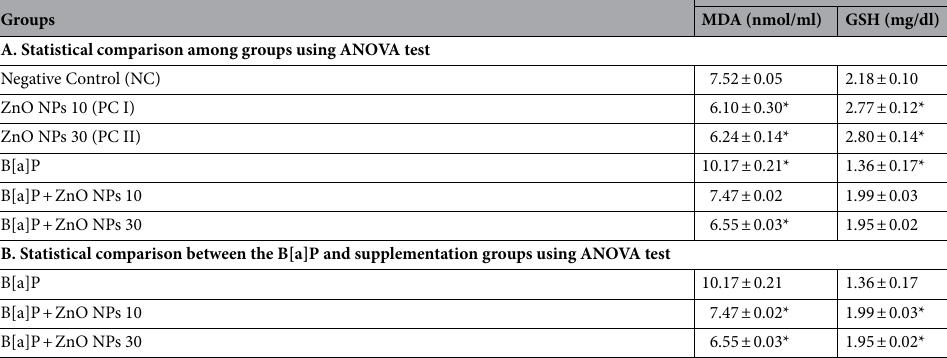
Table 3. Effect of zinc oxide nanoparticles (ZnO NPs) on oxidative stress biomarkers in the serum of benzo [a] pyrene (B[a]P)-challenged male rats. Values are presented as mean ± standard deviation. Values with superscript * within the same column indicates a significant difference from the NC group in table A and from B[a]P in table B at P < 0.05. Abbreviations: MDA: Malondialdehyde; GSH: reduced